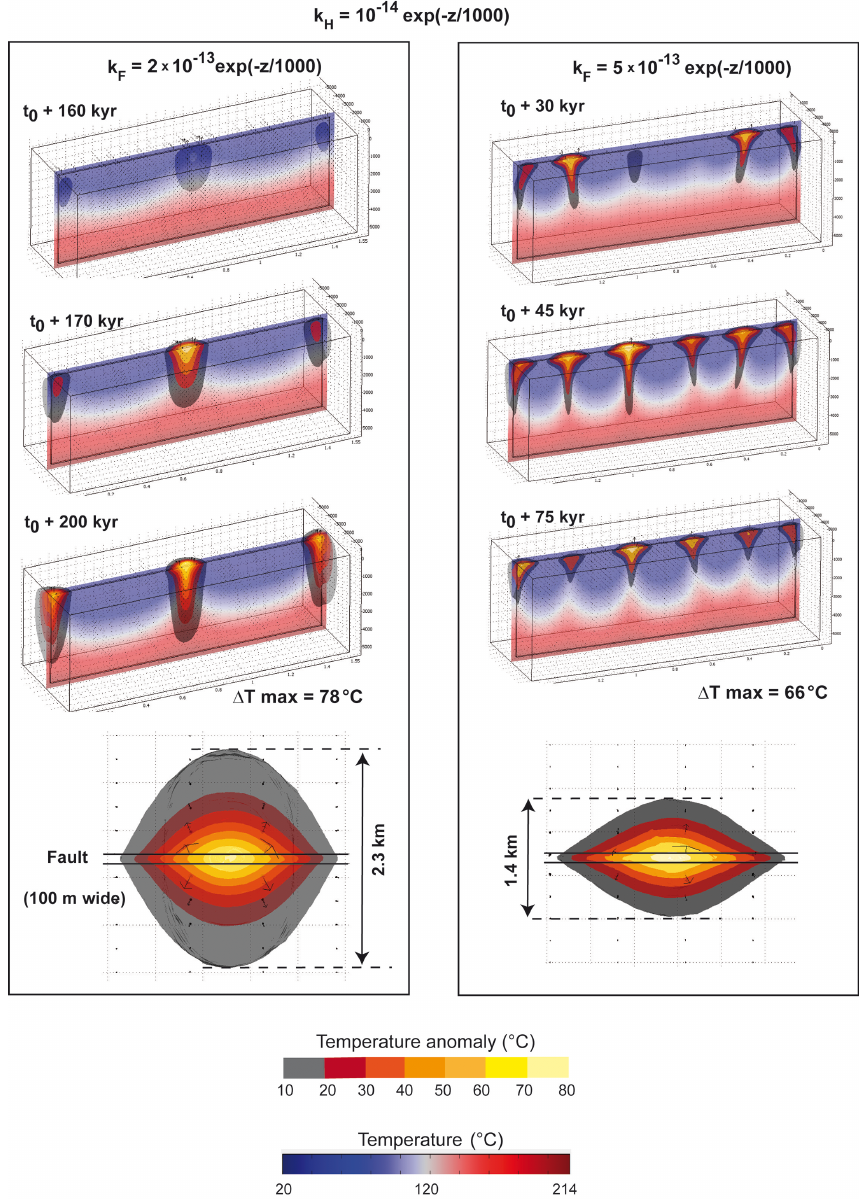
Figure 14. Effect of permeability ratio between a vertical fault zone and the host rocks: k F /k H = 20 (left) and 50 (right). The maximum temperature anomaly is reached at time t 0 + 200kyr (left) and t 0 + 45kyr (right). The bottom images show temperature anomalies from above at a depth of 500m. While the maximum amplitudes of the anomalies do not differ much (66 and 78 ◦ C), the lateral diffusion lengths strongly differ (2.3 and 1.4km